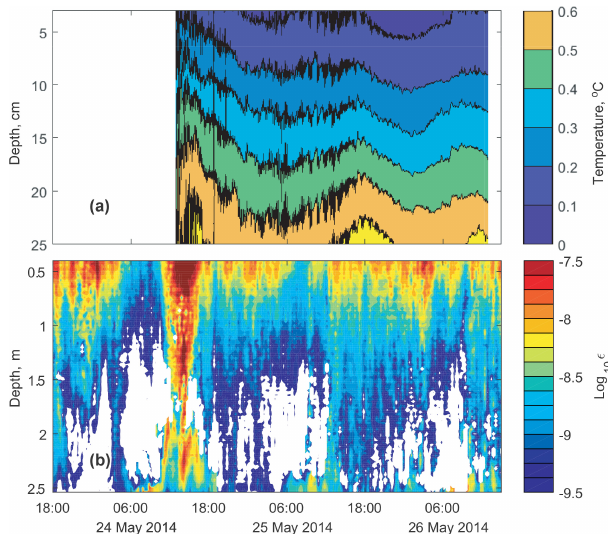
Figure 6. (a) Temperature fluctuations in the IL and (b) TKE dissi- pation rates in the upper water column. In white areas of (b) no de- veloped turbulence could be detected, because no inertial subrange could be identified according to Eq. (5).